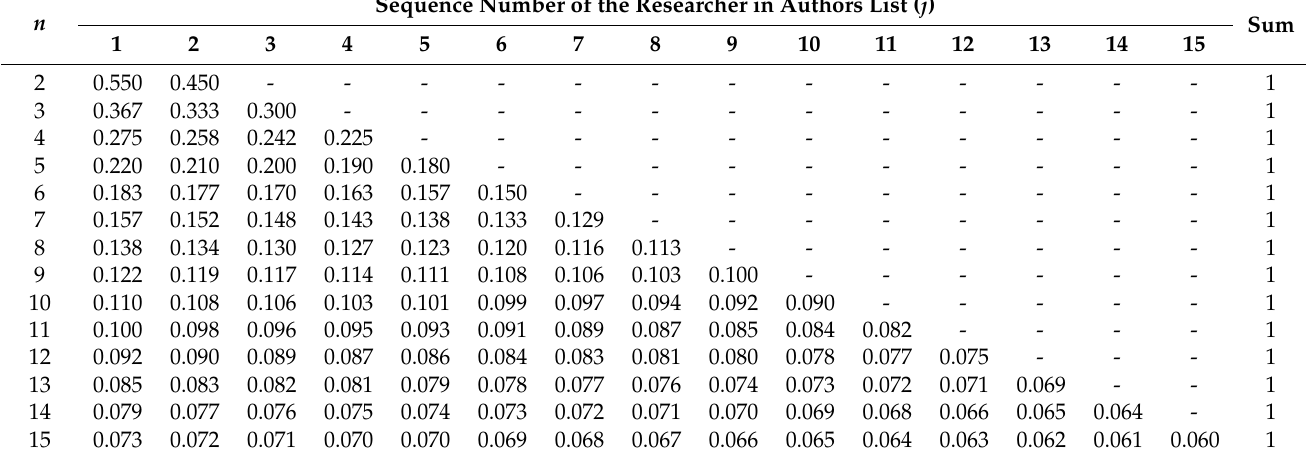
Table 1. Uniformly decreasing distribution of fractional credit shares of a publication among the coauthors (2–15). k = 0.2.